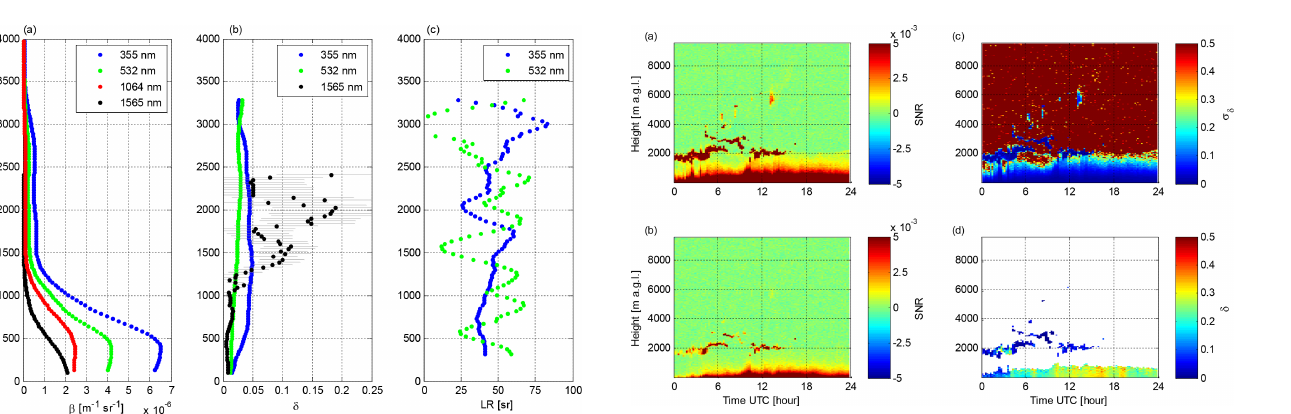
Figure 13. Vehmasmäki 15 May 2016 measurements with Halo Doppler lidar. (a) Time series of co-polar SNR at 350s integration time. (b) Time series of cross-polar SNR at 350s integration time. (c) Uncertainty in the depolarization ratio. (d) Particle linear depo- larization ratio filtered with σ δ < 0 . 05.